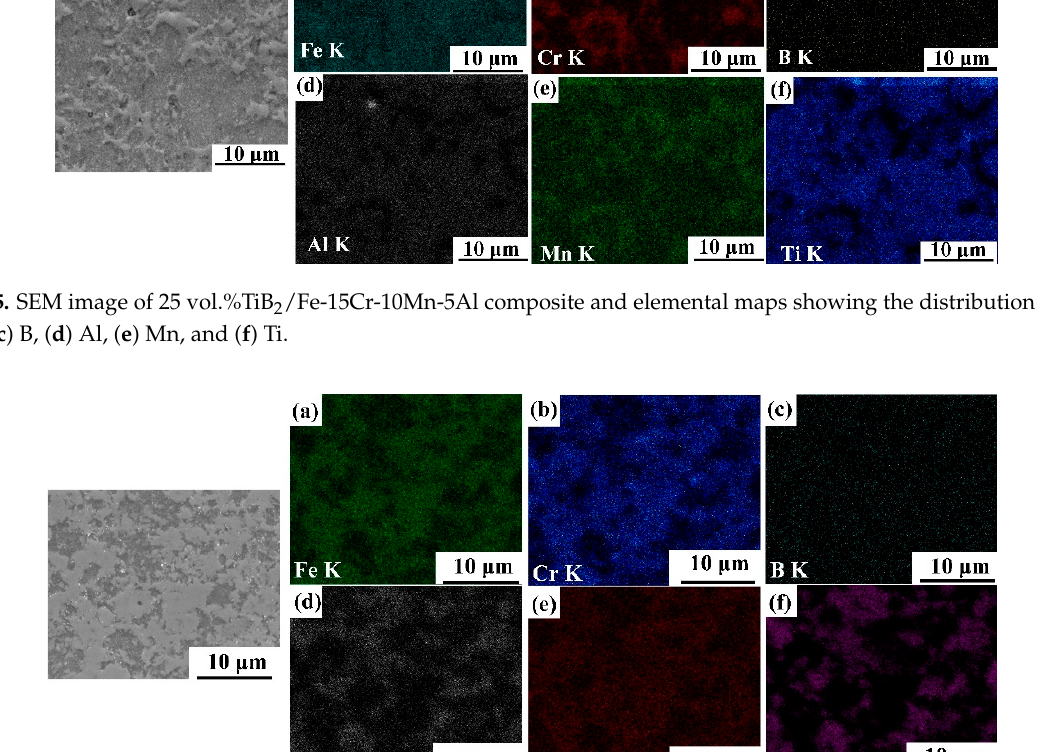
Figure 6. SEM image of 30 vol.%TiB 2 /Fe-15Cr-10Mn-5Al composite and elemental maps showing the distribution of ( a ) Fe, ( b ) Cr, ( c ) B, ( d ) Al, ( e ) Mn, and ( f ) Ti. X-ray diffraction pattern for 25 vol.%TiB 2 /Fe-15Cr-10Mn-5Al composite is shown in Figure 7. CrFeB with orthorhombic crystal structure (a is 1.4534 nm, b is 0.7302 nm, and c is 0.4215 nm), Fe 2 AlCr with cubic crystal structure (a is 0.2894 nm), and TiB 2 with